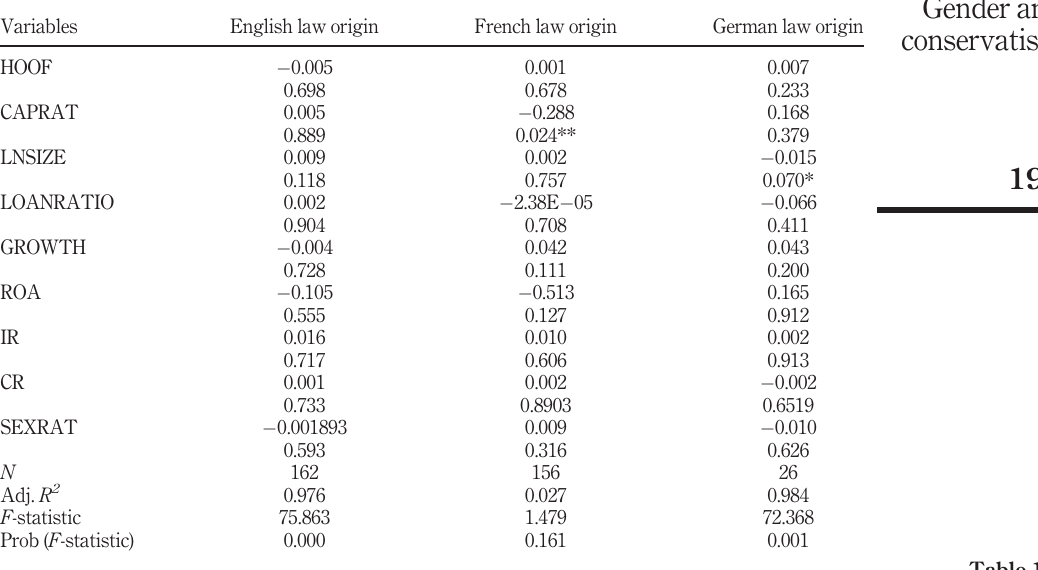
Table 10. Regression result